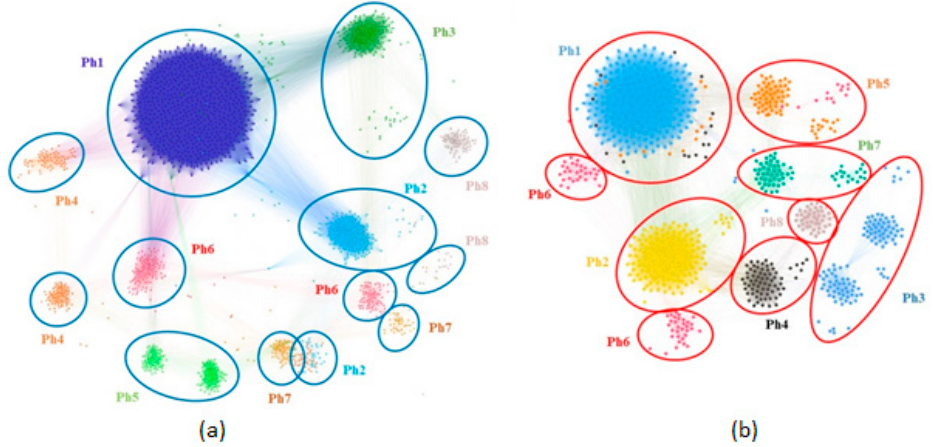
Figure 1. Male and female patient network phenotypes: ( a ) MPN with N = 1948 patients and 8 phenotypes; ( b ) FPN with N = 848 patients and 8 phenotypes.